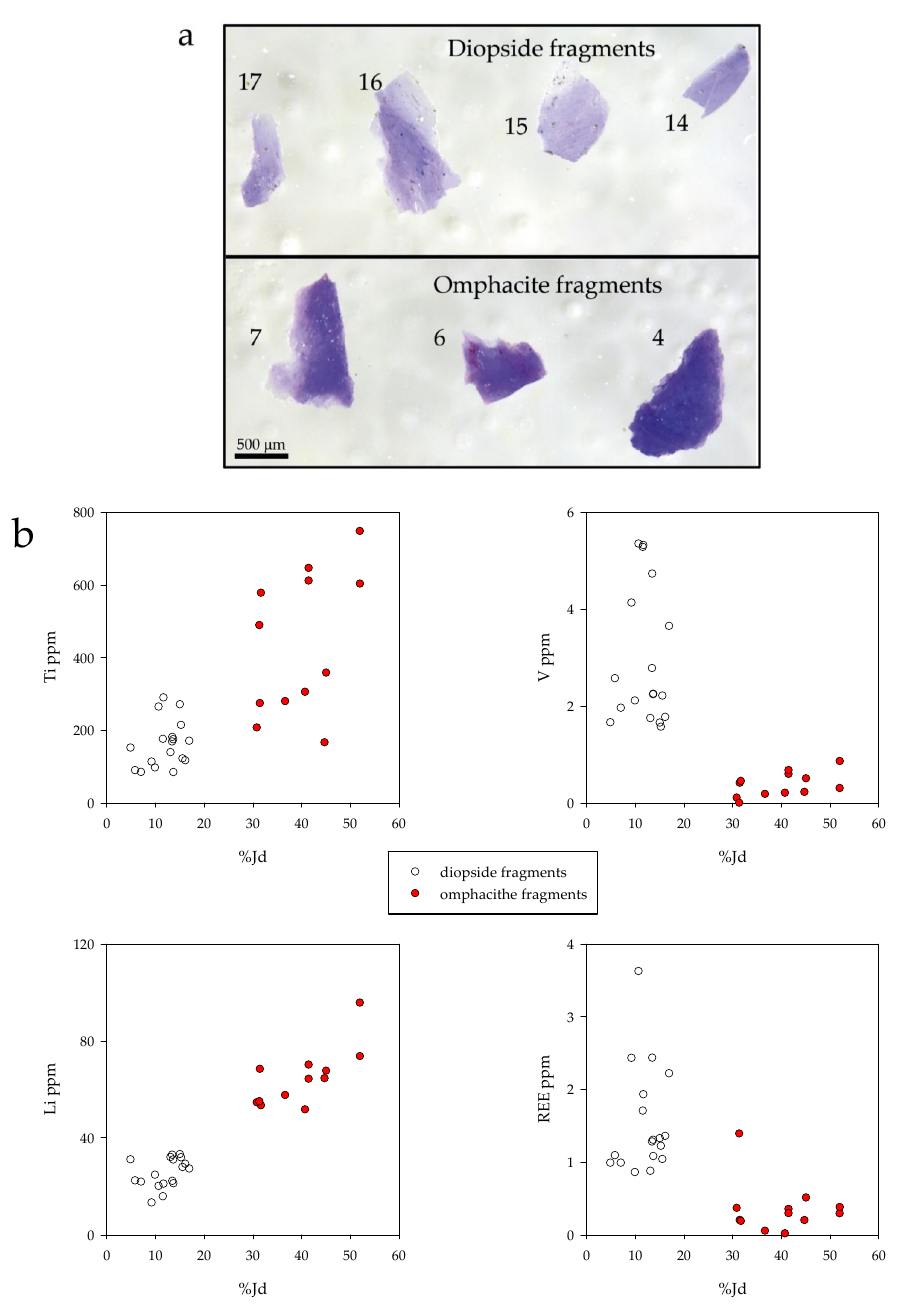
Figure 9. Optical microscope images of selected diopside and omphacite fragments ( a ) and variation of their content of Ti, V, Li, and REE vs. the mole % of the jadeite component (%Jd) (mol%) ( b ).